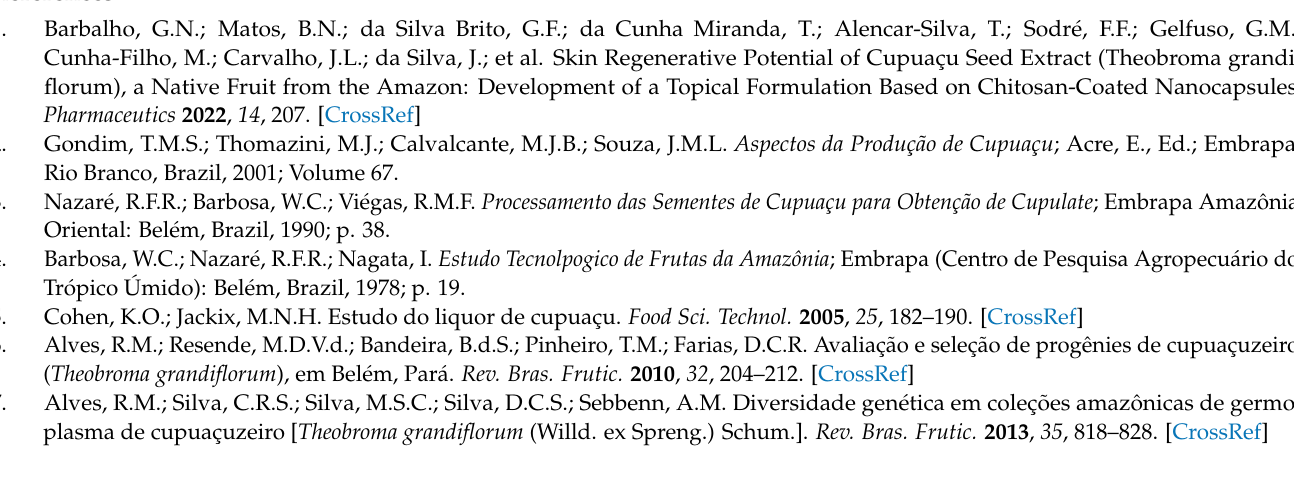
Table S2. Primers used in this study. F: forward. R: reverse. Table S3. Amplicon characteris- tics. Figure S1. Relative expression of selected cupuassu genes in pulp samples from the 174 and 1074 genotypes through fruit maturation. Lower- and upper-case letters indicate statistical values for the 174 and 1074 genotype samples, respectively. Different letters indicate significant differences between samples by the Scott–Knott test ( p ≤ 0.01). (*) indicates samples with only two repeti- tions. Figure S2. Relative expression of selected cupuassu genes in seed samples from the 174 and 1074 genotypes through fruit maturation. Lower- and upper-case letters indicate statistical values for the 174 and 1074 genotype samples, respectively. Different letters indicate significant differences between samples by the Scott–Knott test ( p ≤ 0.01). (*) indicates samples with only two repetitions. Table S4. Gene Ontology (GO) of the cupuassu sequences used in this study. Table S5. ESTs expressed in the seed, testa, and/or pulp of T. cacao showing orthology with the T. grandiflorum sequences used in this